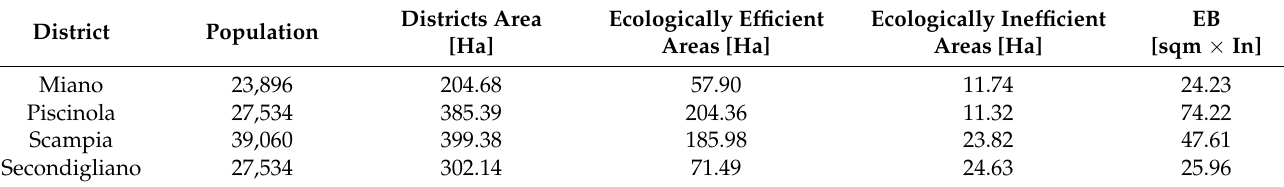
Table 4. Statistics of districts by uncultivated area.